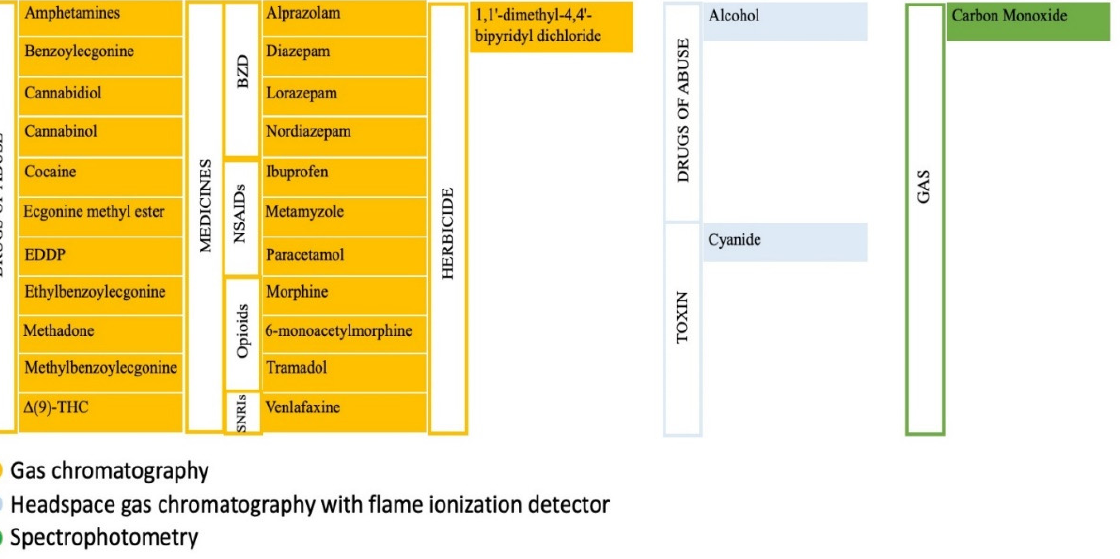
Figure 2. Classification of the different toxics analyzed in this study and the analytical techniques used for their laboratory determination. EDDP, 2-etileno-1,5 dimetil 3-3 difenilpirrolodina; ∆ (9)-THC, Δ (9)-tetrahidrocannbinol.